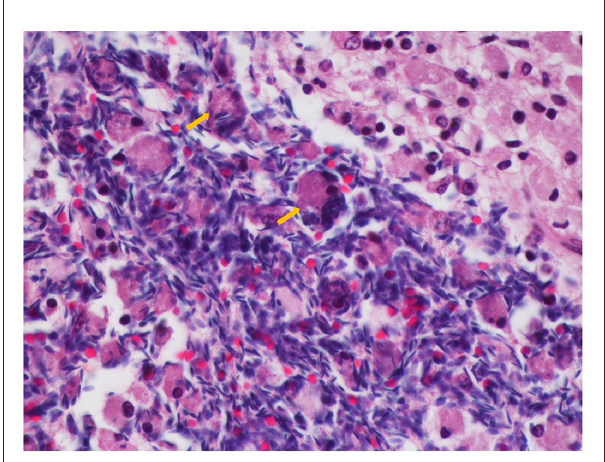
FIGURE4 Foreign body inflammatory reaction in response to sperm extravasation, consisting of numerous multinucleated giant cells (arrows) (H&E,